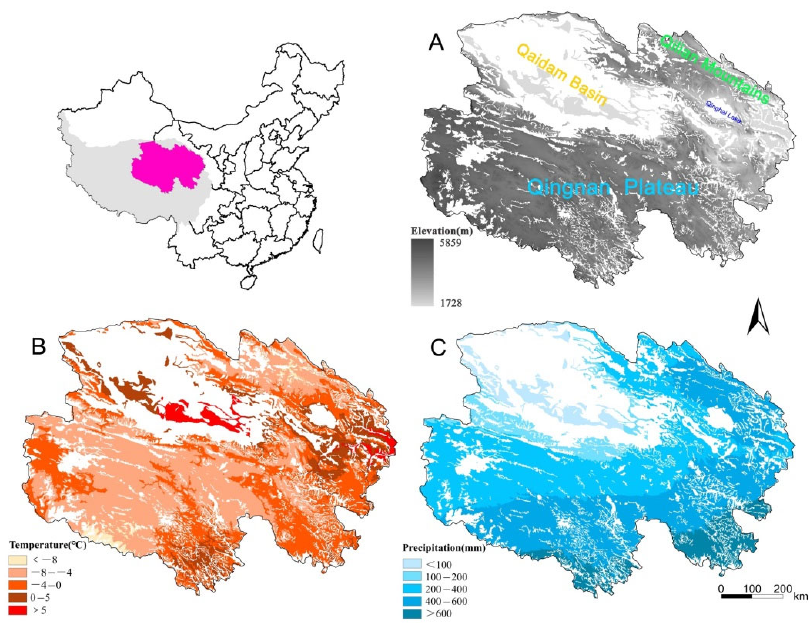
Figure 1. Elevation ( A ); average annual temperature ( B ); and average annual precipitation ( C ) in the Qinghai grasslands from 1979 to 2018.